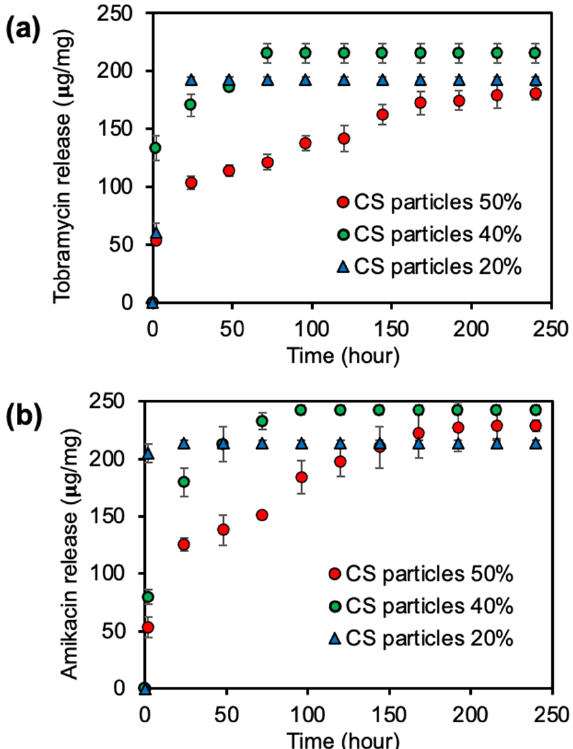
Figure 3. Drug release profiles of ( a ) CS-Tobramycin, and ( b ) CS-Amikacin particles crosslinked at 50, 40, and 20% mole ratios in pH 7.4 PBS at 37.5 °C.